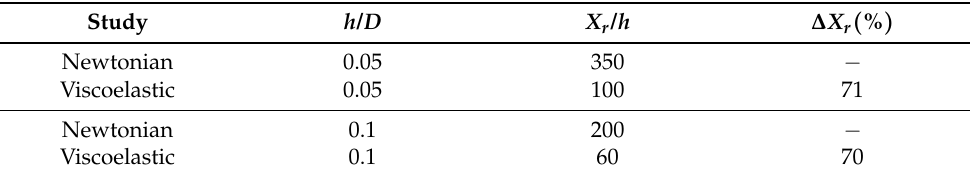
Table 4. The recovery locations compared between Newtonian and viscoelastic flows, for both roughness